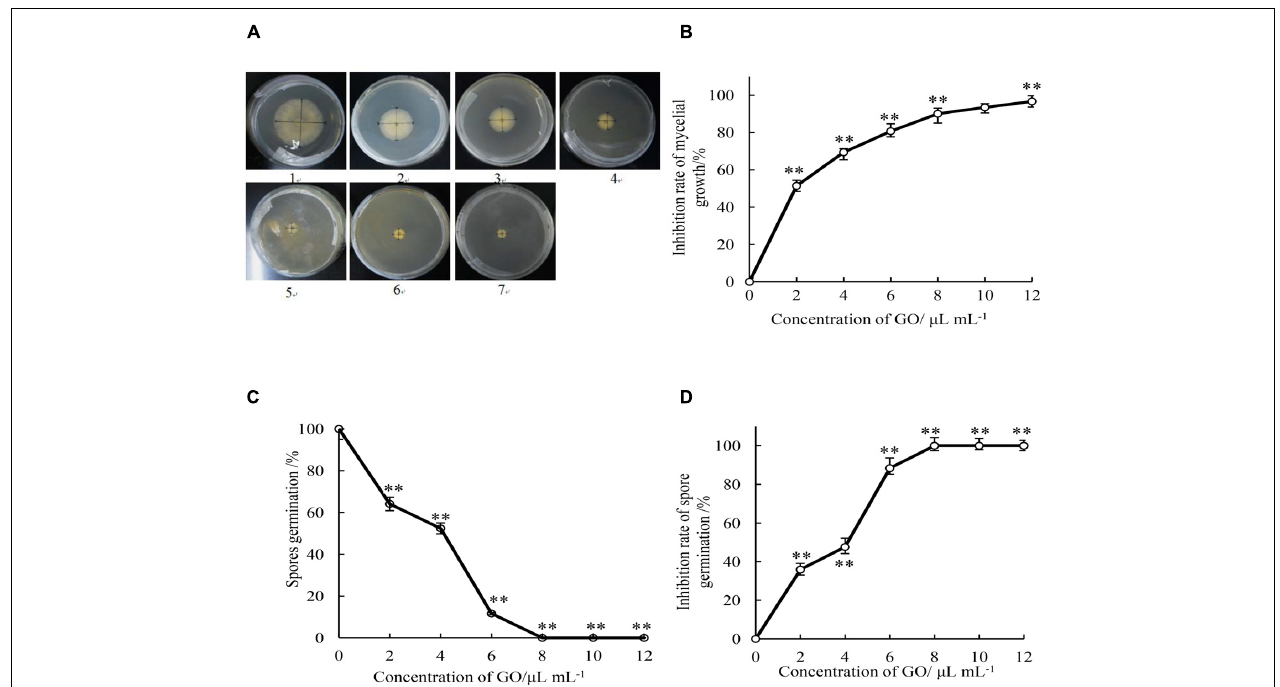
FIGURE 1 | Effects of different concentrations of GO on colony diameter (mm) (A) , inhibition rate of mycelial growth (B) , spore germination rate (C) , and inhibition rate of spore germination (D) of P. microspora. Each value is the mean for three replicates. The vertical bar indicates the standard error. The asterisks indicate significant difference between control and GO treated fruit ( ∗∗ P < 0.01). Plate of 1 in Figure 1A represented the treatment of propylene glycol was for control. Plates of 2 to 7 represented the treatments of GO with concentration of 2, 4, 6, 8, 10, and 12 µ L per mL propylene glycol, respectively.